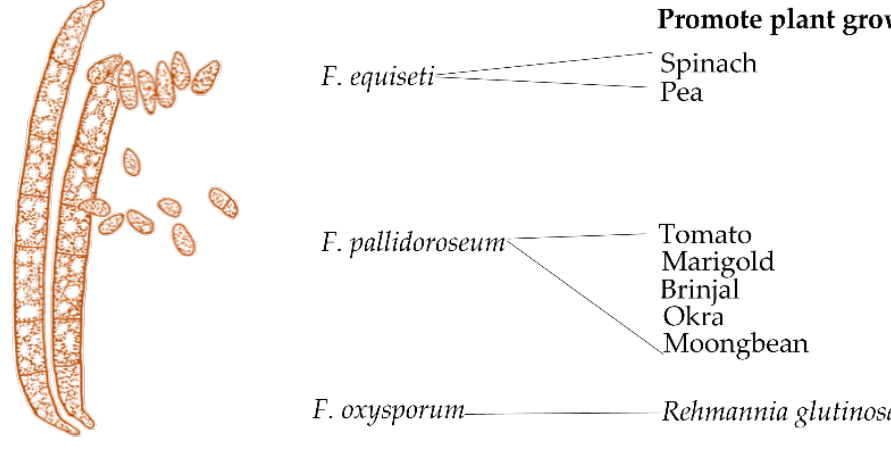
Figure 4. Species of the genus Fusarium used in the promotion of plant growth.